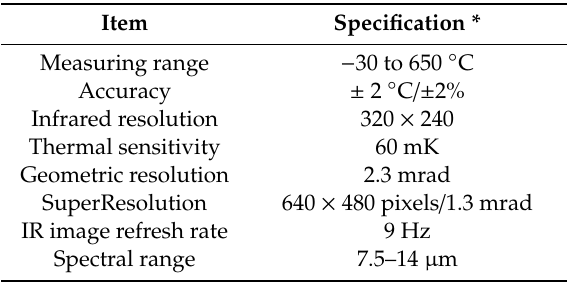
Table 3. Specification and measurement parameters of Testo